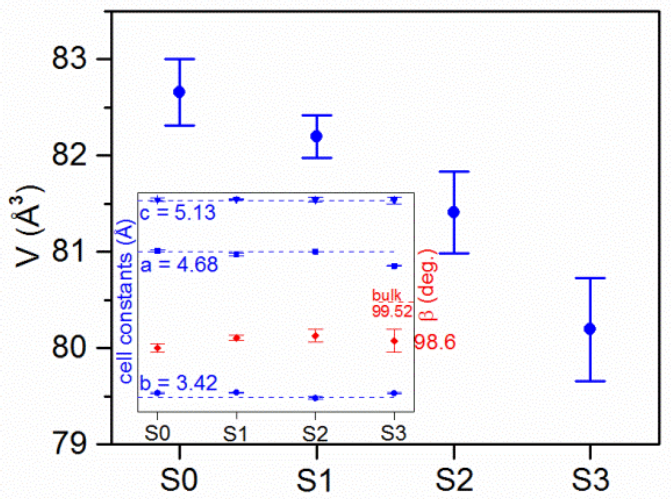
Figure 5. Changes in cell volume of CuO phase with an increase of gallium concentration. Insert presents the cell parameters of copper